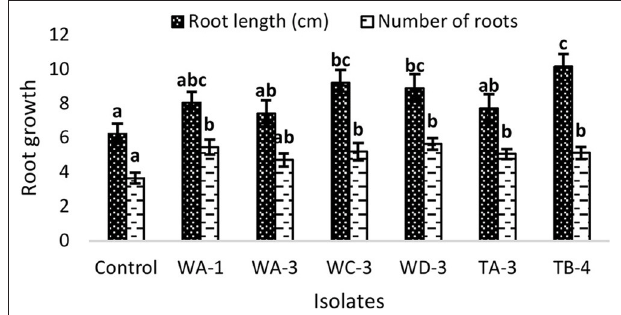
FIGURE 3 | Effect of actinomycetes spore suspension on seed germination of Triticum aestivum . Bars represents mean ± SE of three replicates (15 plants). Different letters on bars indicate significant difference between treatments, using Duncan’s multiple range test ( P = 0.05).